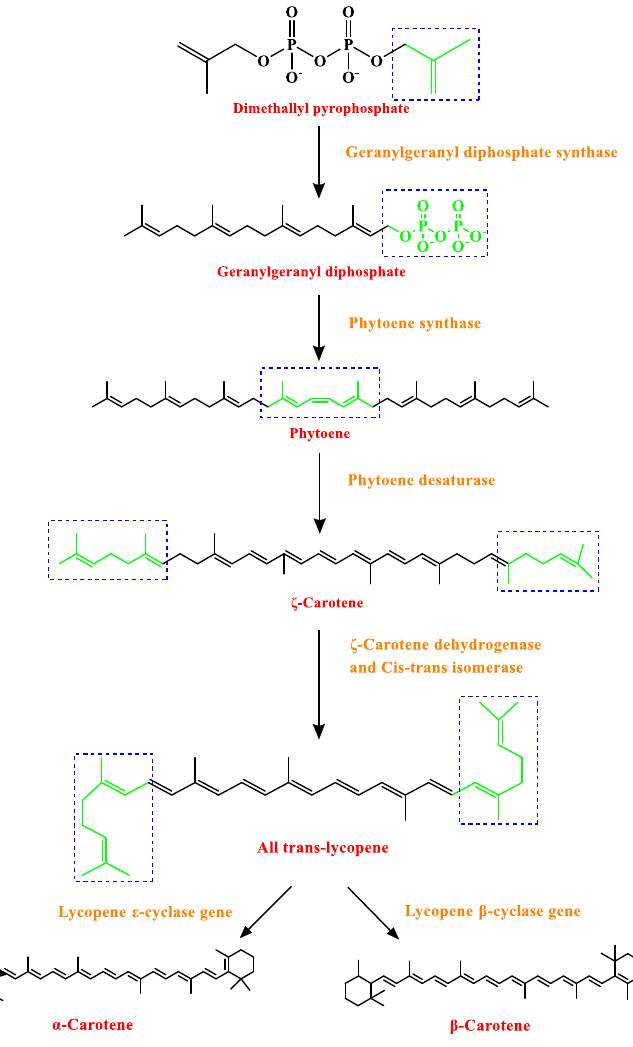
Figure 3. The metabolic processes of